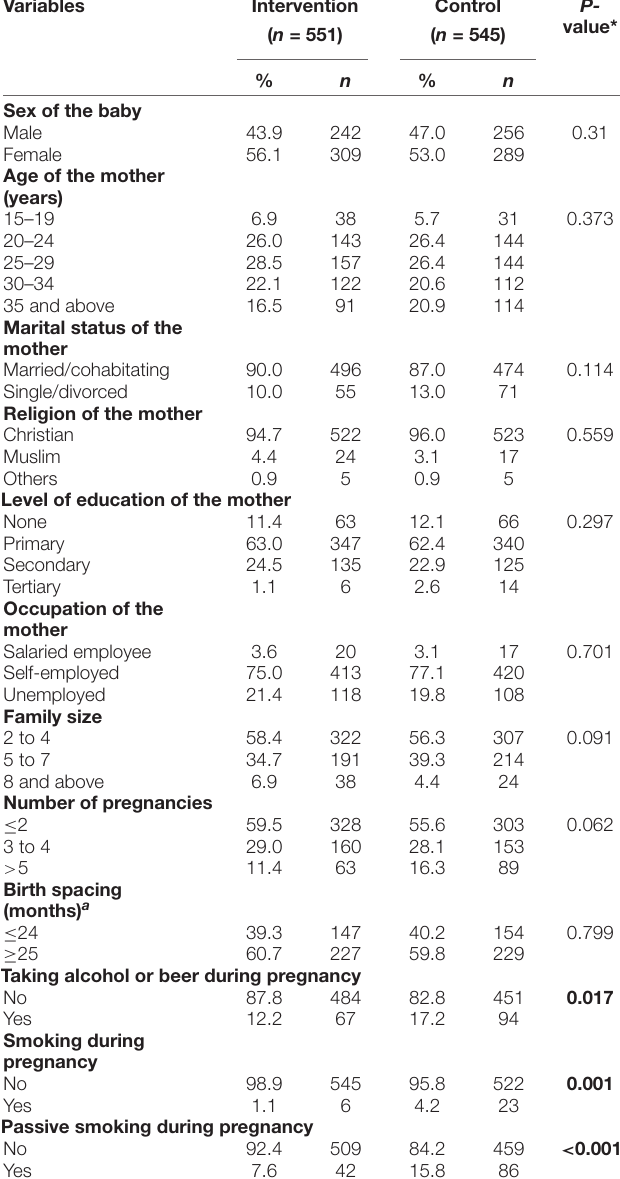
TABLE 1 | Socio-demographic, obstetric and lifestyle characteristics of the study population.